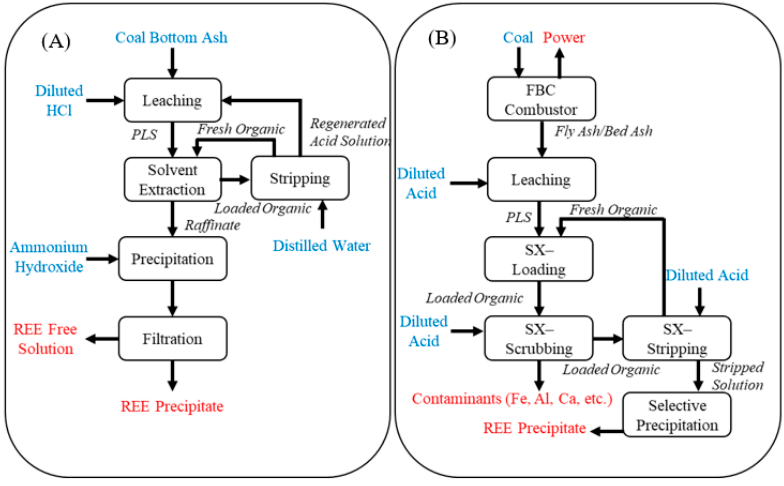
Figure 7. Flowsheets reported in the literature for recovering REEs from coal combustion ash using acid leaching: ( A ) reported by [97] and ( B ) reported by